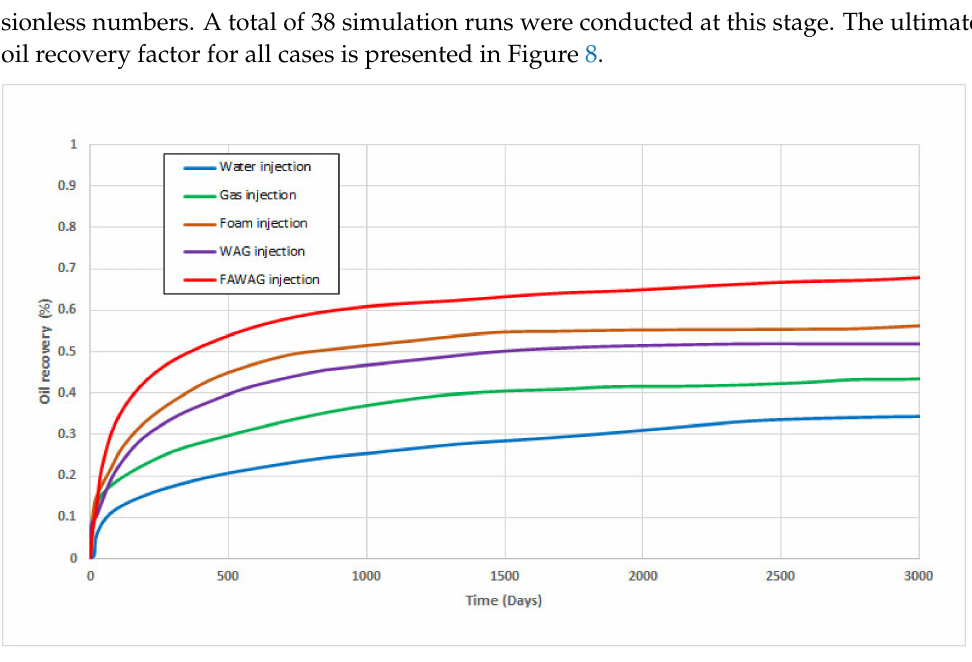
Figure 8. Ultimate oil recovery for all